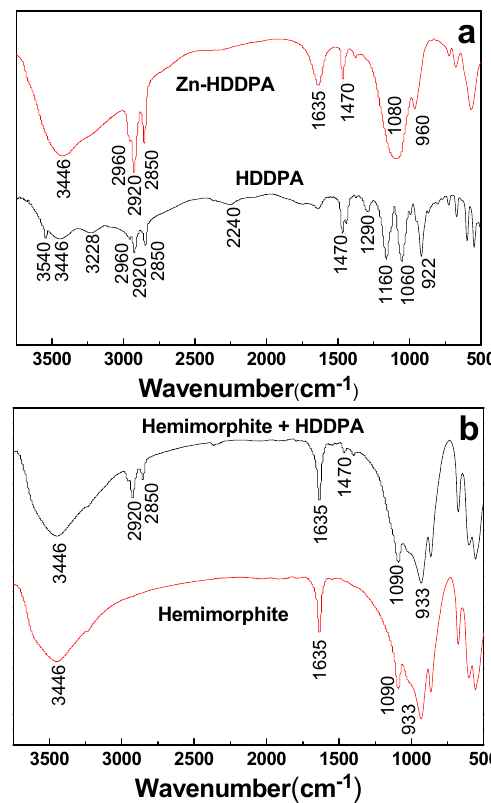
Figure 7. Fourier transform infrared (FTIR) spectra of HDDPA and Zn-HDDPA precipitate ( a ), hemimorphite before and after HDDPA adsorbed ( b ).